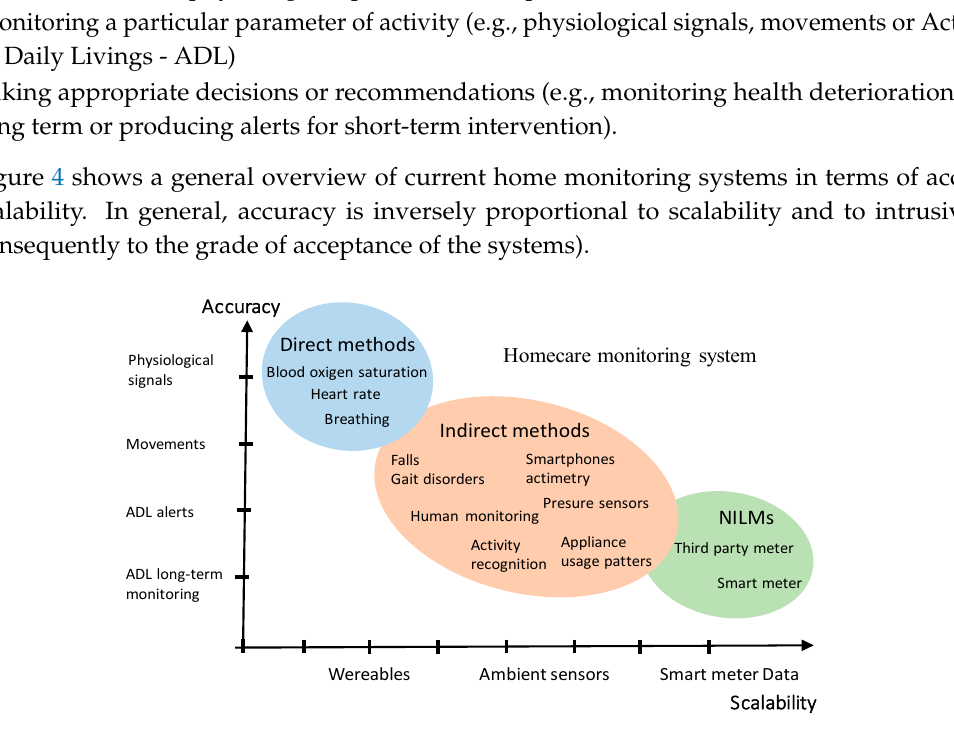
Figure 4. General overview of current homecare monitoring systems for AAL depending on accuracy and scalability (adapted from [129]).